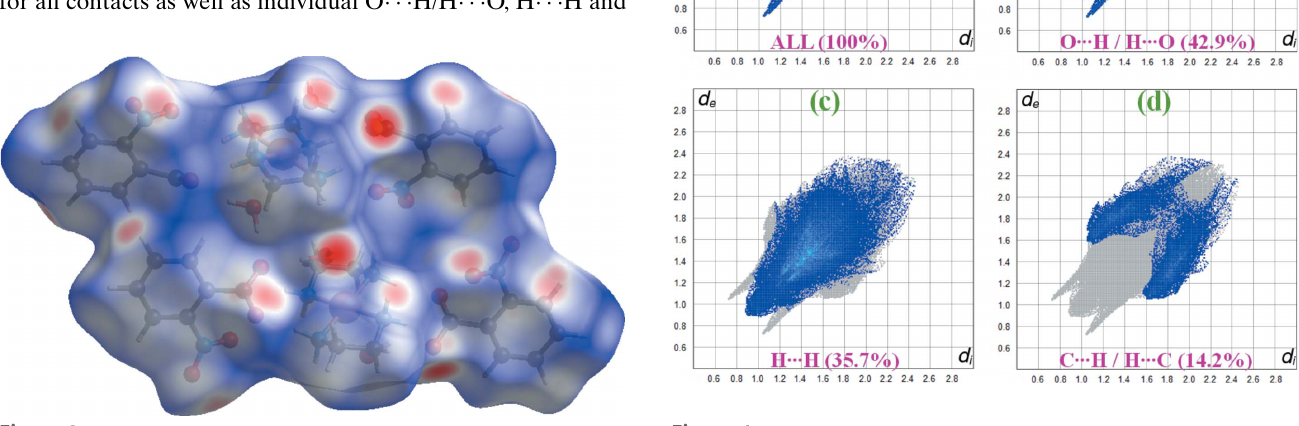
Figure 3 View of the Hirshfeld surface mapped over d norm in the range (cid:5) 0.6381 to +1.2243 (arbitrary units).